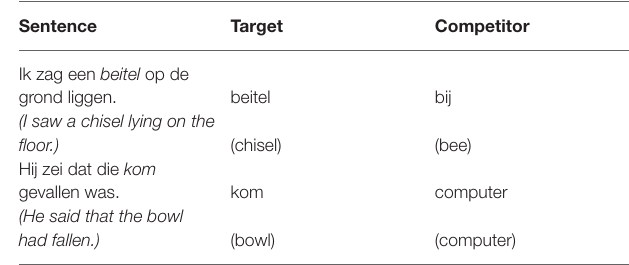
TABLE 4 | Example of sentences containing both a polysyllabic and a monosyllabic target